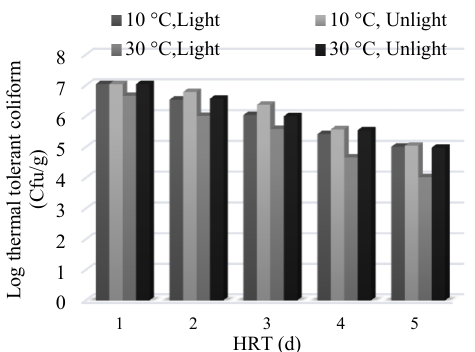
Fig. 2. Changes in thermophilic coliform in FAS under different conditions (pH = 7.1–8)